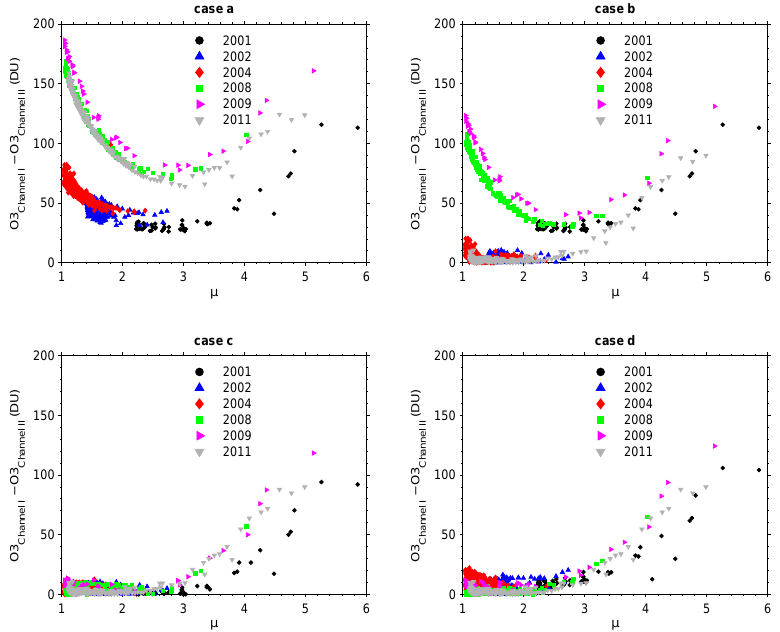
Fig. 5. Evolution of the differences in the total ozone content between Channel I and Channel II retrievals versus airmass for different cali- bration schemes. Case a, using the original calibration from 1997; Case b, using a step by step calibration; Case c, using linear interpolation with time between the calibrations; and Case d, using a linear interpolation between calibrations made in 1997 and 2010.